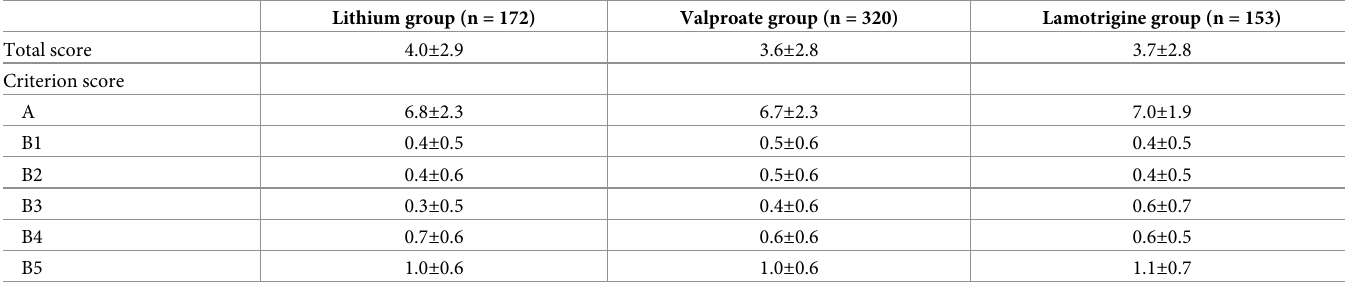
Table 2. Total and individual criterion scores on the treatment response